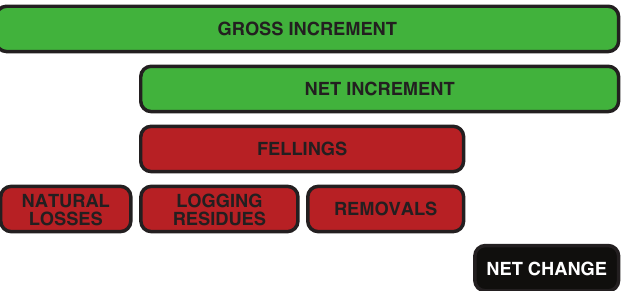
Figure 1. Schematic composition of increment and fellings reproduced from the “State of Europe Forests 2015” report